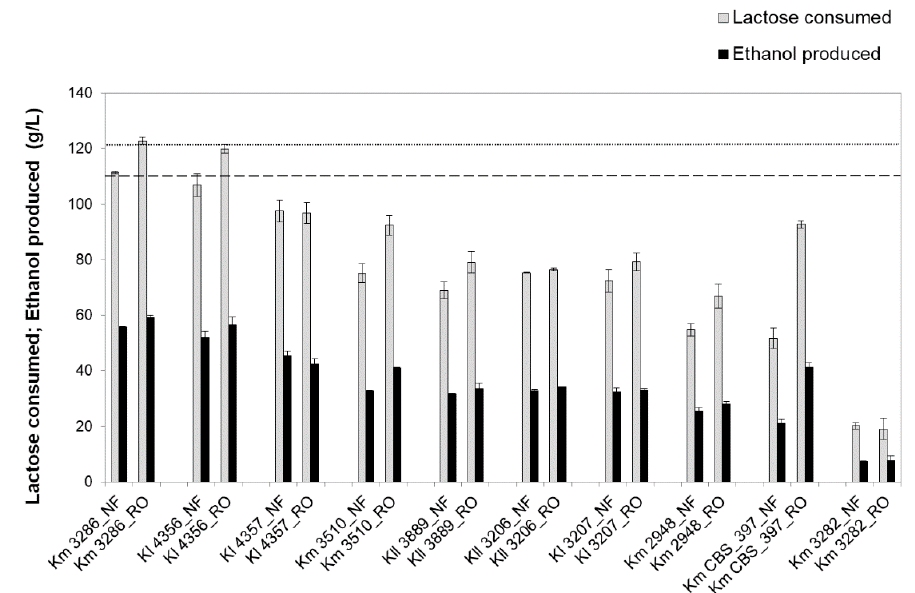
Figure 1. Lactose consumed (gray bars) and ethanol produced (black bars) at 16 h fermentation in the NF and RO media. Km, K. marxianus PYCC strain; Kl, K. lactis PYCC strain; Kll, K. lactis var. lactis PYCC strain; dash line, average initial lactose concentration in the assays in NF retentate; and dot line, average initial lactose concentration in the assays in RO retentate. Error bars represent standard deviation from the average value of three independent experiments.